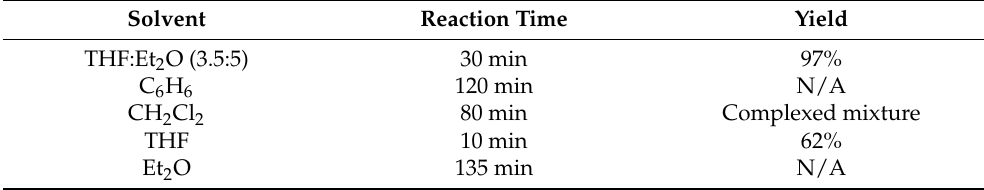
Table 4. The influence of the reaction media on the outcome of the dimerization process. Solvent Reaction Time